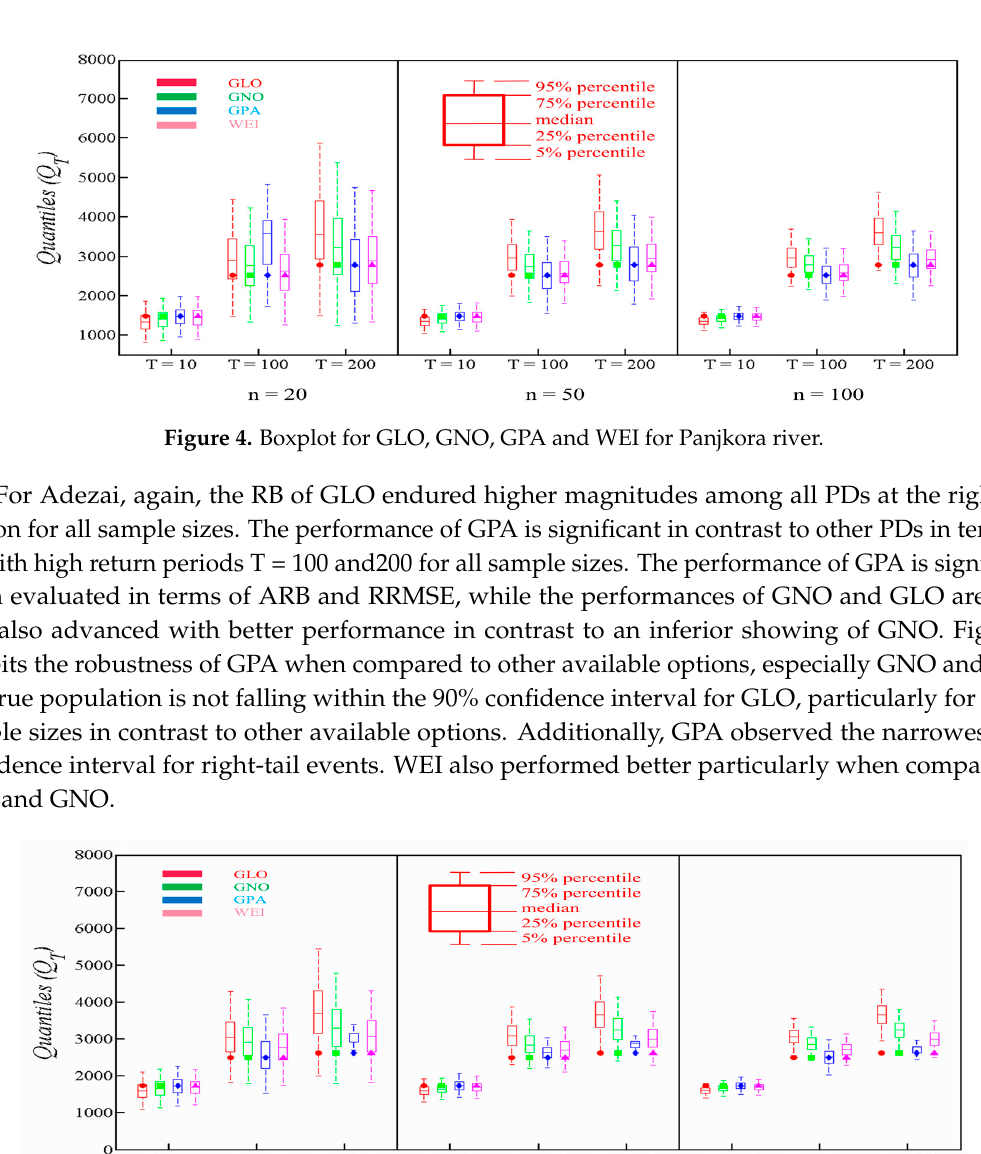
Figure 5. Boxplot for GLO, GNO, GPA and WEI for Adezai river.